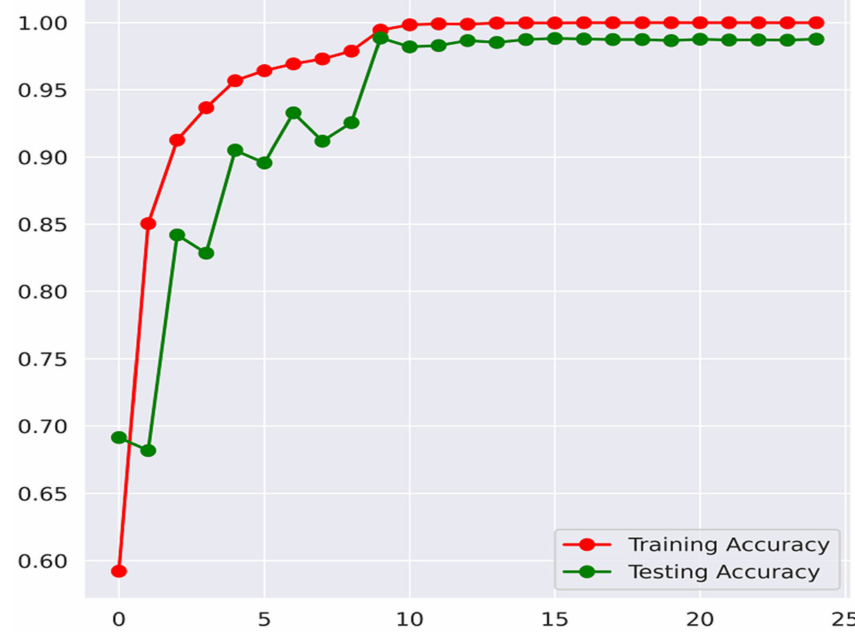
Figure 4. Accuracy graph for training and testing for protocol-I.